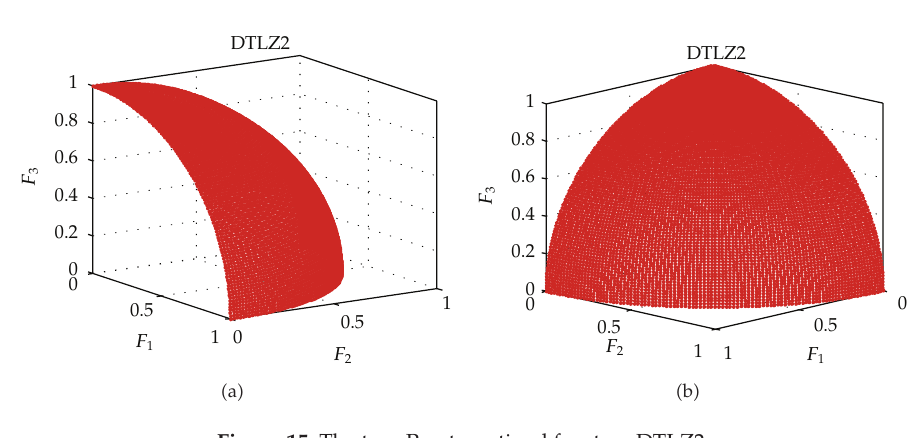
Figure 15: The true Pareto optimal front on DTLZ2.